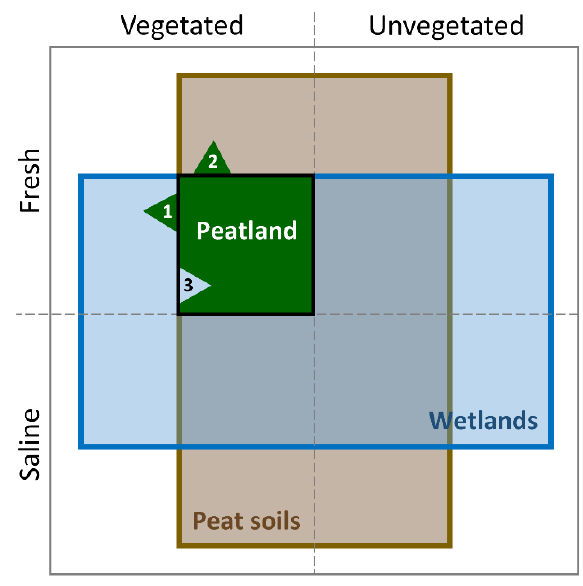
Figure 1. The scope of the Peatland Evidence Synthesis (dark green area) includes vegetation in peatlands (areas with non-saline, wet, peat soils; black box), typical peatland vegetation that is not currently on peat soil (e.g. restoration after some mining activities; arrow 1) and fen meadows (which may sit at the wetland-upland boundary; arrow 2). However, the synthesis does not include wetland vegetation types that sometimes, but often do not, occur on peat soils (e.g. reedbeds; arrow 3). Note that peatlands are often defined as any area with peat soil (brown box) and that our definition is closer to the mire and suo/swob concepts used elsewhere (Joosten et al . 2017). Figure adapted from Bragg & Lindsay